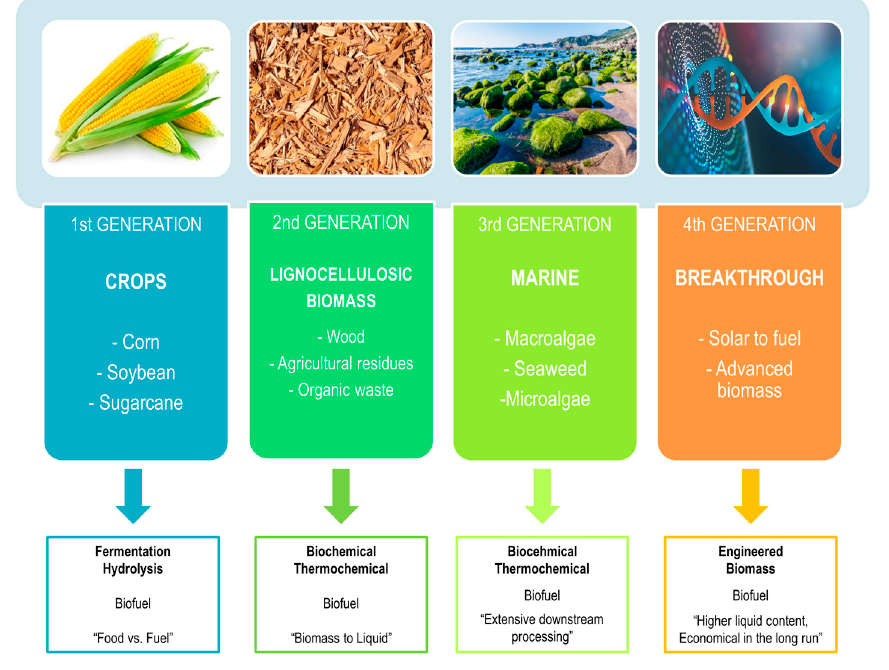
Figure 2. Generations of